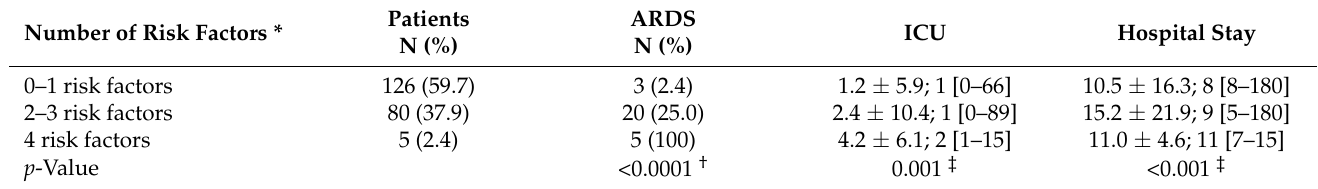
Table 5. Rate of ARDS and days in ICU and hospital according to number of risk factors for